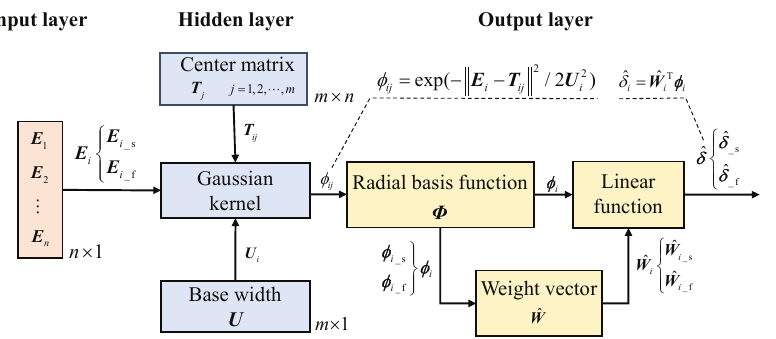
Figure 1. Online operational structure of the RBFNN.